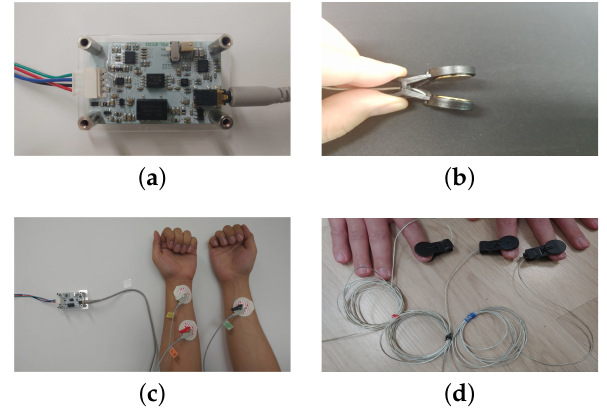
Figure 2. ECG signal measuring circuit and two type of electrodes on the wrist and on the fingers: ( a ) ECG measuring circuit; ( b ) electrode as a button style (which can be patched on the fingers); ( c ) measuring ECG signals on the wrist; ( d ) measuring ECG signals on the fingers.